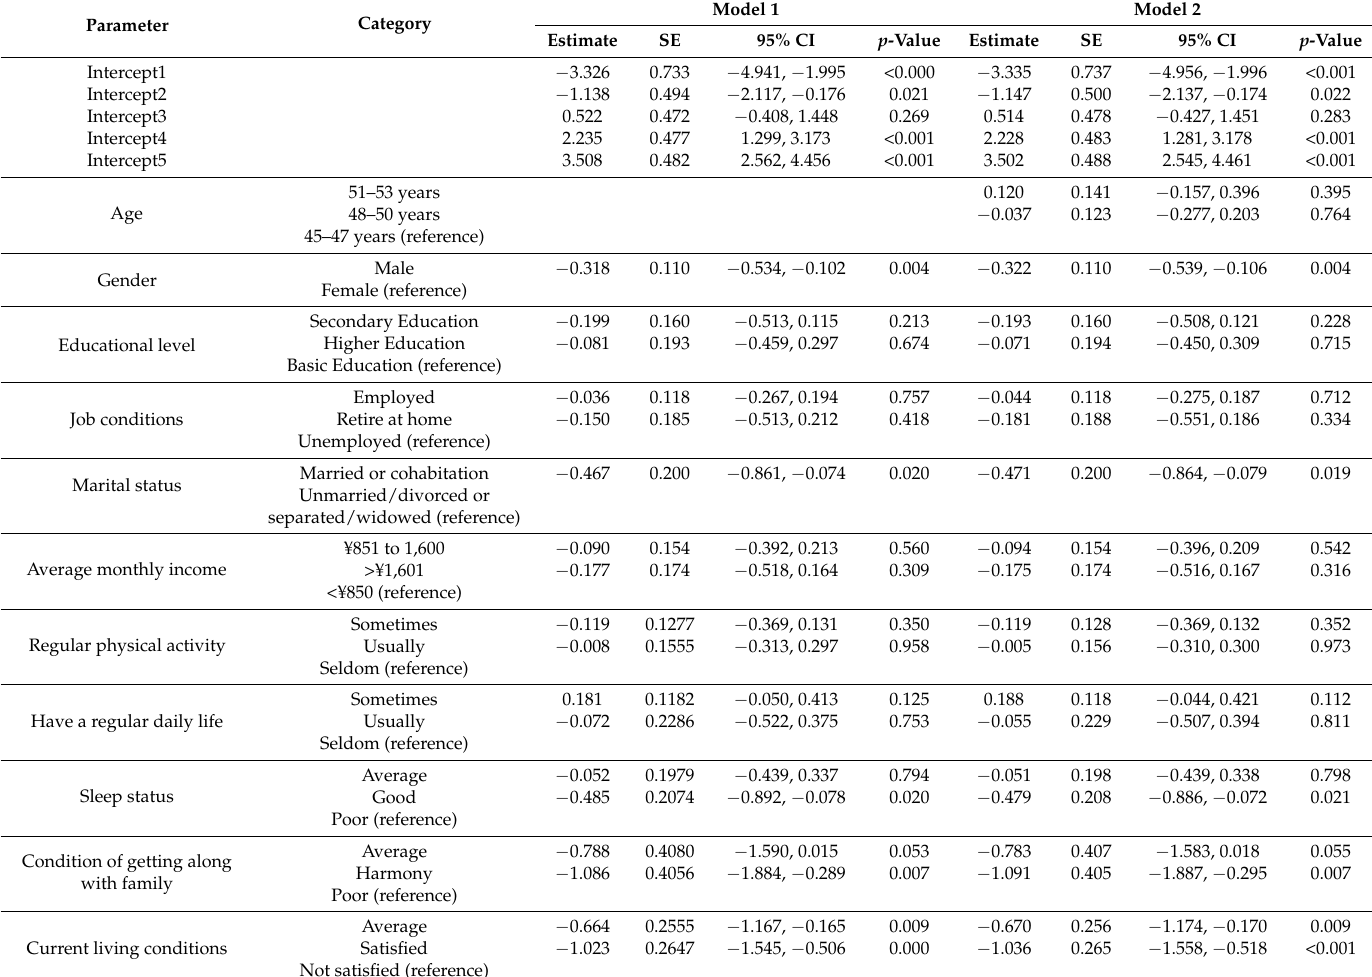
Table 2. Ordered Multivariate logistic regression analysis of body pain intensity in adults (45–53 years old) in Chongqing,